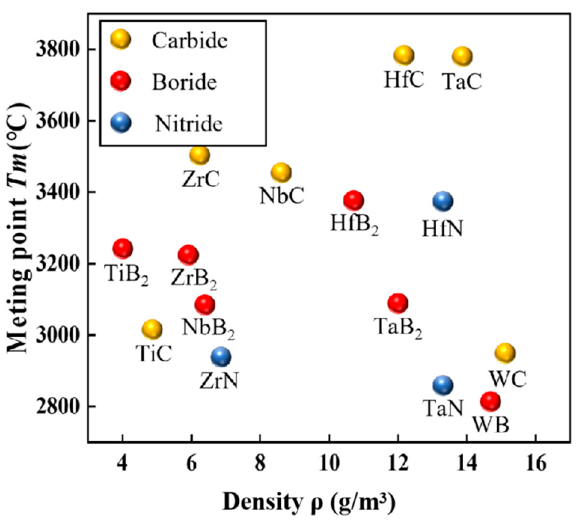
Figure 1. Comparison of melting points and density of metals ultra-high temperature ceramics.